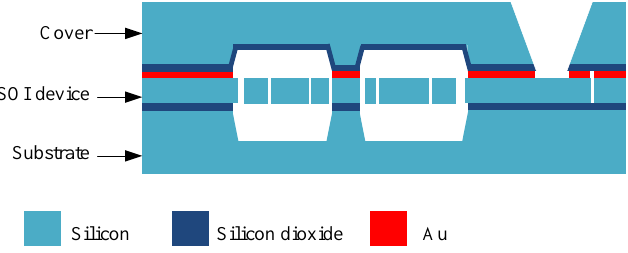
Figure 2. SOI-MEMS (silicon-on-insulator microelectromechanical system) process cross-section of the die.